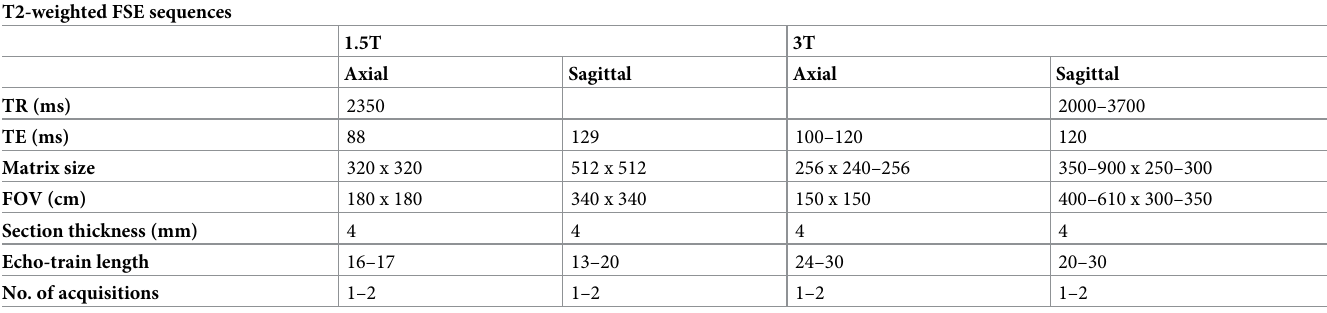
Table 2. 1.5T and 3T lumbar MRI acquisition